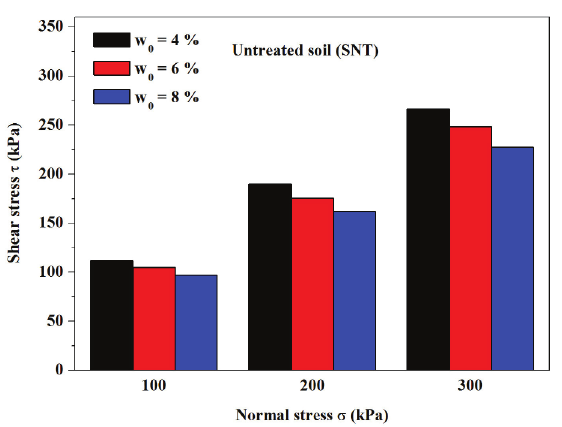
Table 6: Values of the collapse potentials.